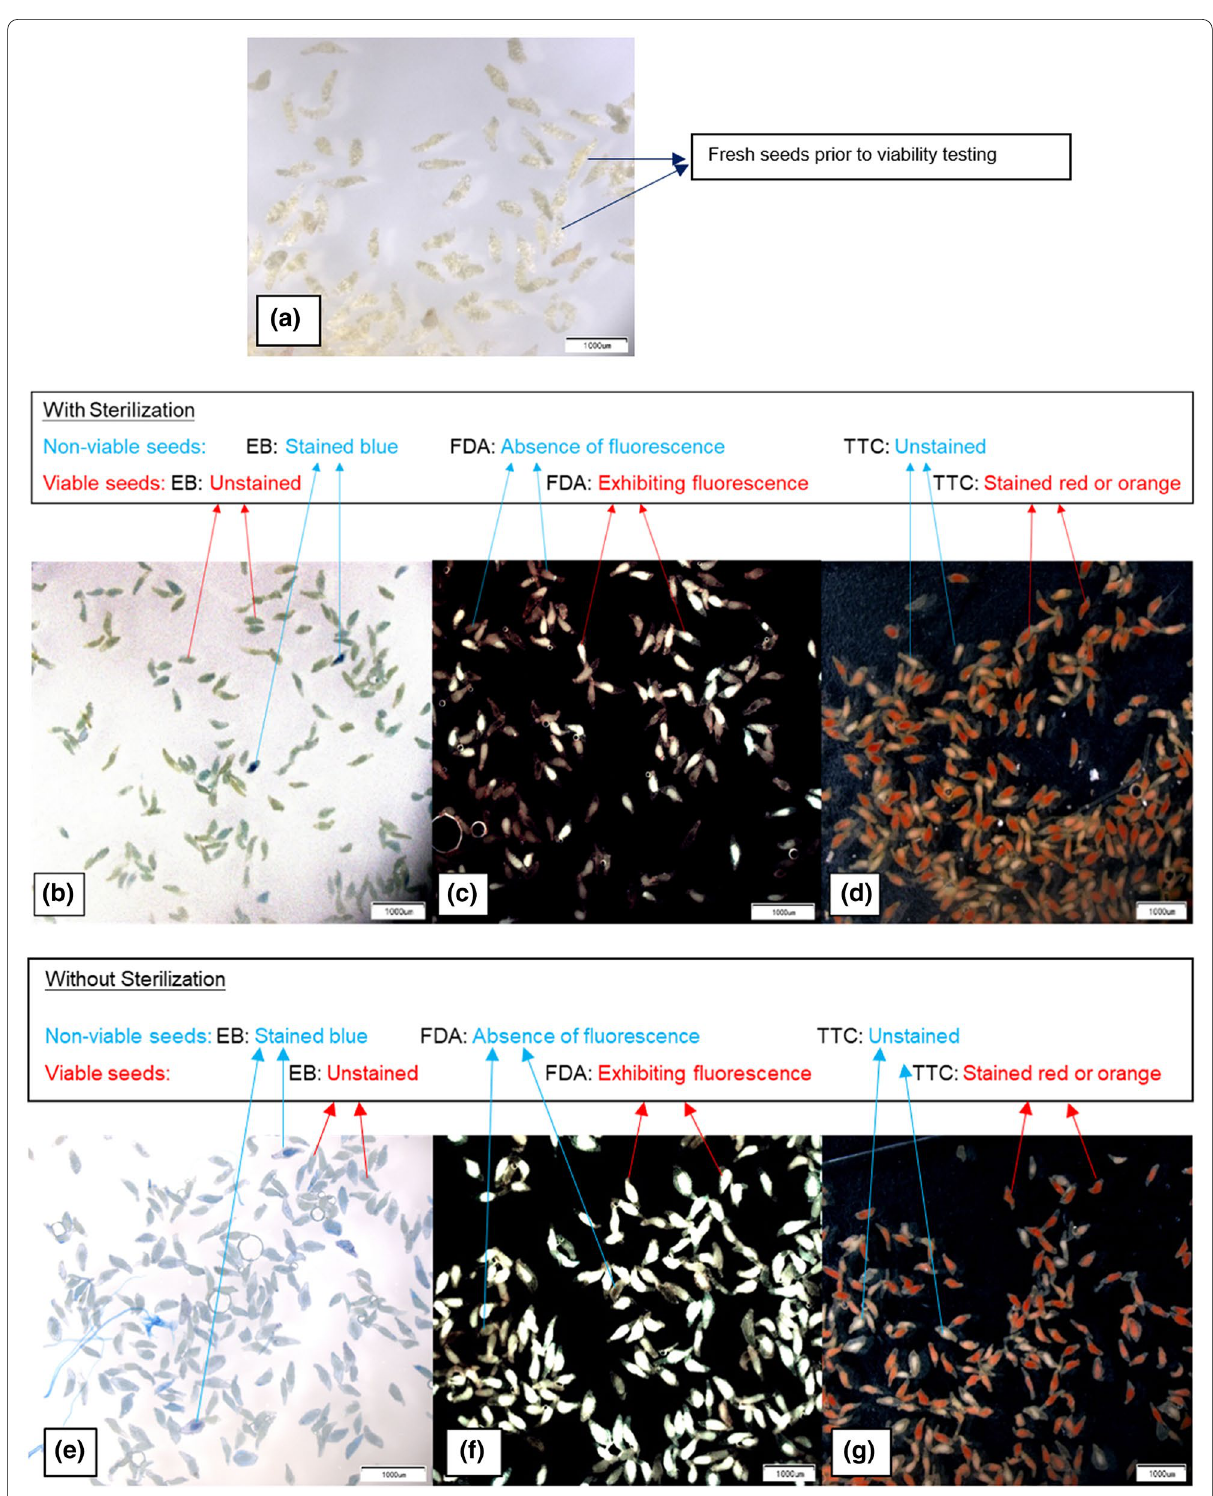
Fig. 1 A–G Images of seeds of Cymbidium floribundum , one of the study species subjected to viability testing. A Fresh seeds prior to experimentation. B–D Results of viability tests; Evans blue test (EB), Fluorescein diacetate test (FDA) and Tetrazolium test (TTC) performed respectively, after sterilizing the seeds. E – G EB, FDA and TTC test performed respectively, without seed